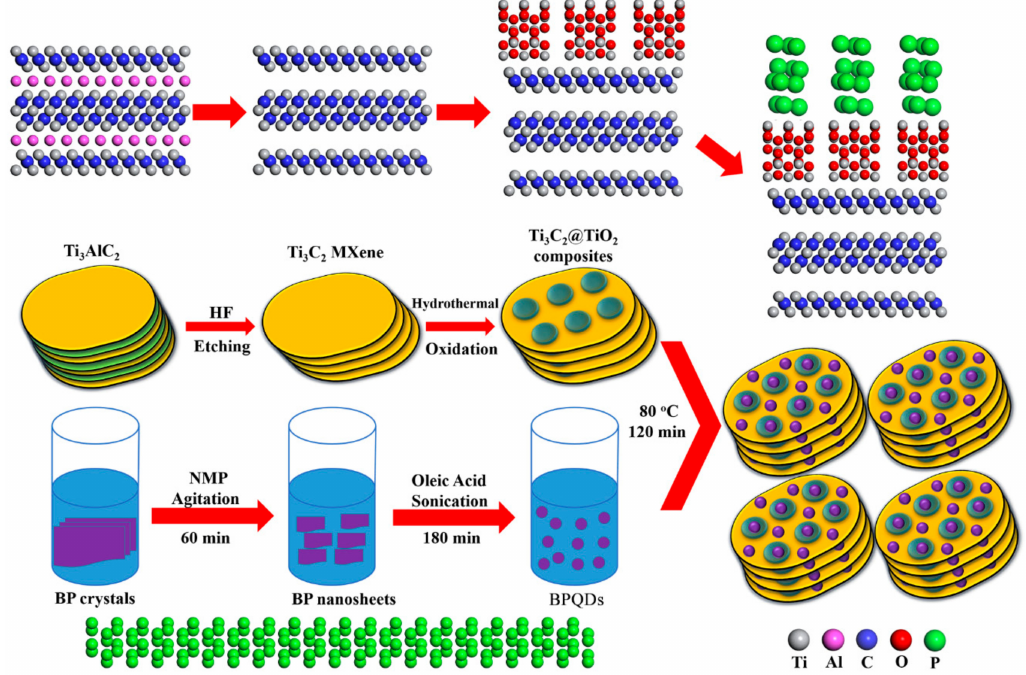
Figure 1. Schematic illustration of the preparation of BPQDs / Ti 3 C 2 @TiO 2